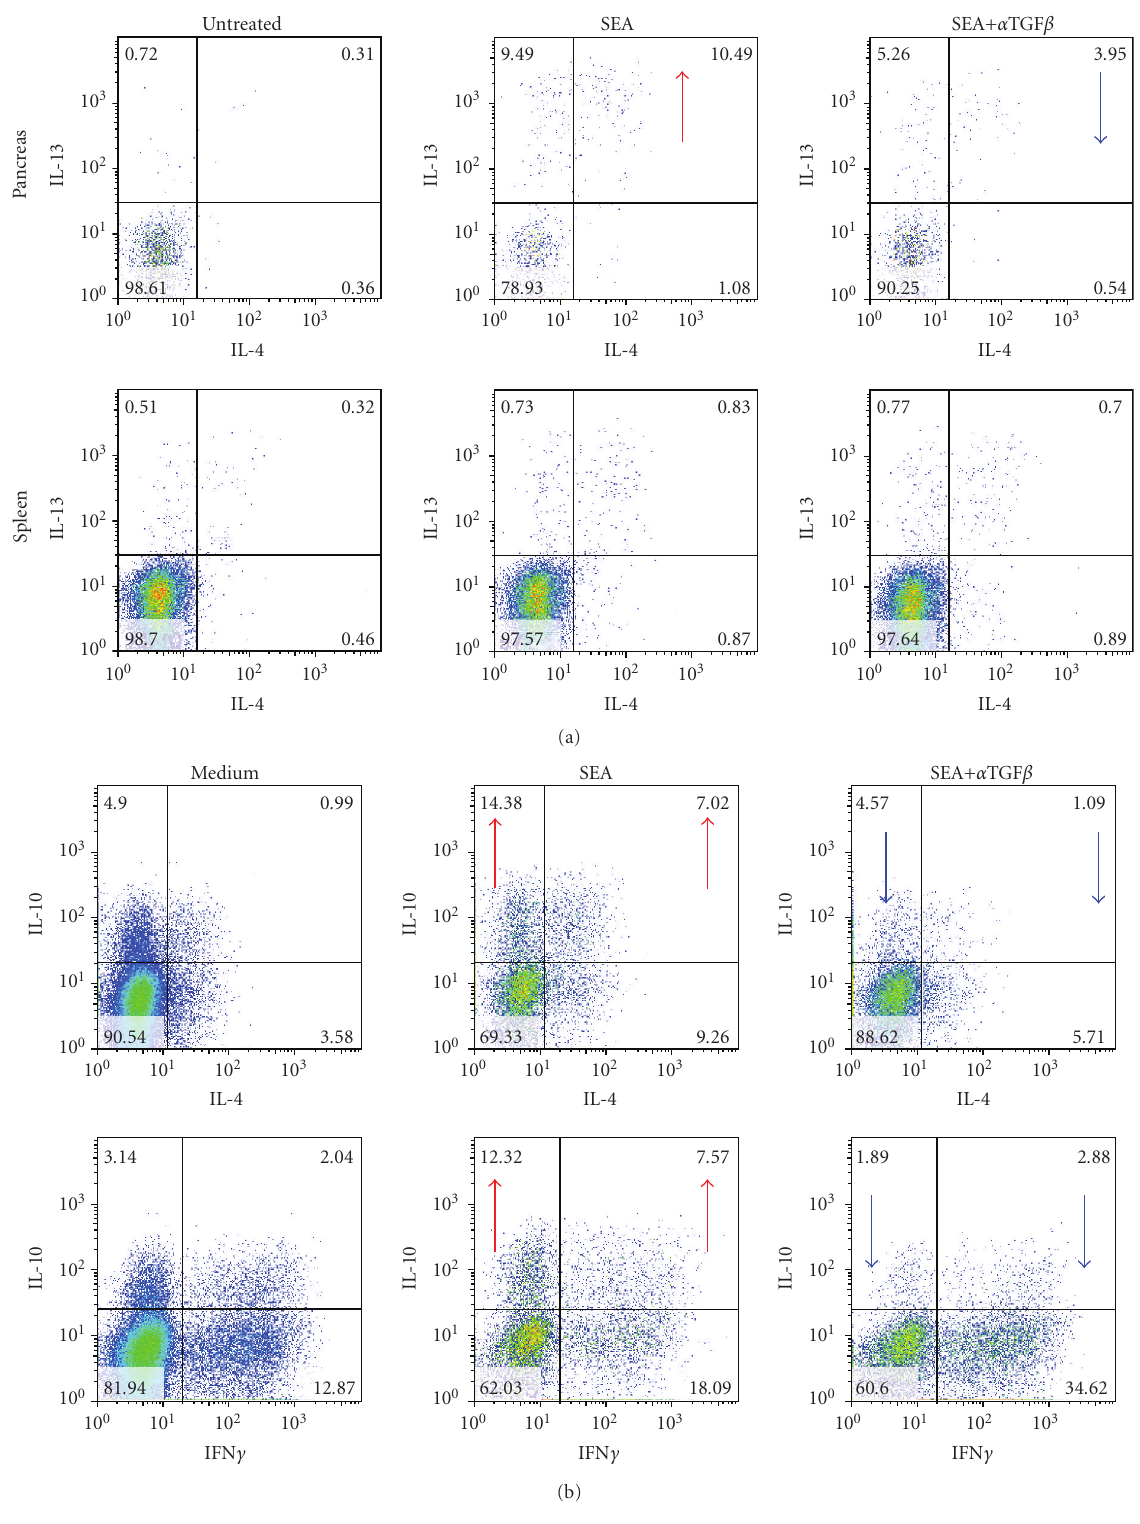
Figure 5: TGF β modulates the Th2 response to SEA in vitro and in vivo. (a) Treatment of NOD mice with anti-TGF β reduces the Th2 response to SEA in vivo. Female NOD mice (10-11 weeks of age) were injected i.p. with 50 μ g SEA on days 0 and 5, 5 mg anti-TGF β on days 0, 2, and 5, and cells were taken for analysis on day 10. Data shown are from a single experiment using anti-TGF β and SEA. (b) Antibody neutralization of TGF β in vitro diminishes the Th2 response to SEA. Na¨ıve CD4 + T cells (5 × 10 5 ) were cultured for five days with bmDCs (10 5 ) and 0.5 μ g/ml α CD3 in the presence of SEA (10 μ g/ml) and/or anti-TGF β (20 μ g/ml). FACS plots from one of three independent polarization experiments are